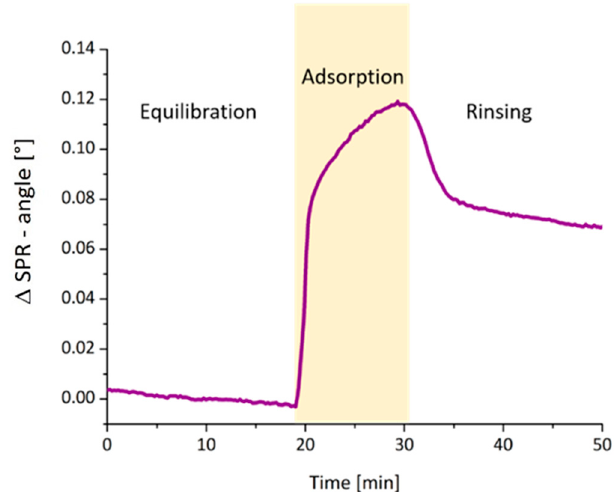
Figure 1. SPR-Sensogram showing the adsorption of GM (c = 1.0 mg · mL − 1 , flow rate 20 µ L · min − 1 ) onto cellulose surfaces measured by MP-SPR with λ = 785 nm using PBS as running buffer.